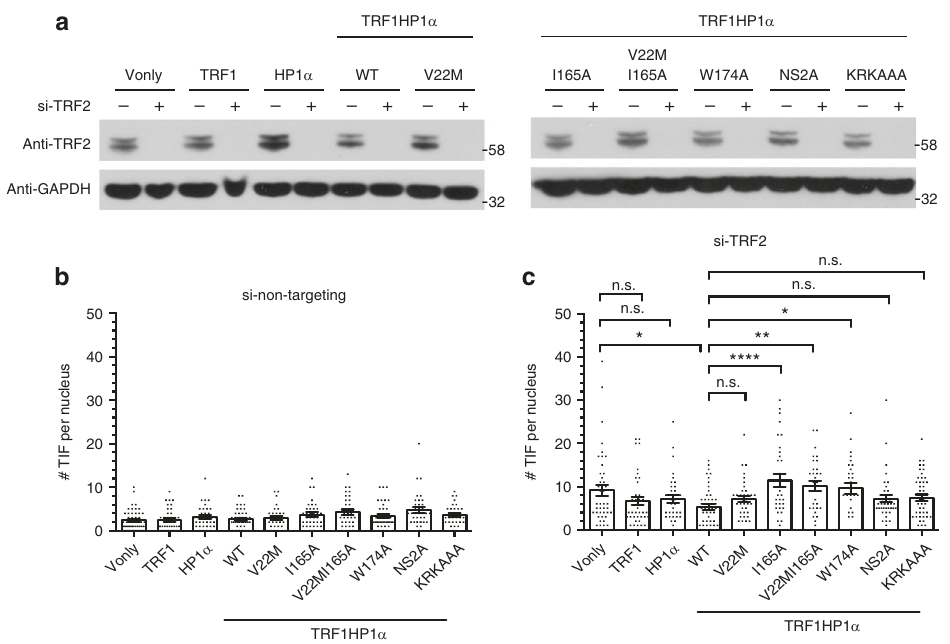
Fig. 5 TRF1HP1 α allele-speci fi c protection effects upon si-TRF2-induced telomeric damage. 72 h after transfection, a TRF2 knockdown ef fi ciency with antibody against TRF2 (anti-TRF2) and GAPDH (anti-GAPDH) as loading control. ( − ) si-non-targeting; ( + ) si-TRF2. Quanti fi cation of TIFs in b si-non- targeting ( n = 32 – 47 nuclei per group) or c si-TRF2. Left * p = 0.0188, right * p = 0.0192, ** p = 0.0042, **** p < 0.0001 ( n = 31 – 48 nuclei per group). b , c Signi fi cance is assessed by one-way ANOVA and Dunnett ’ s multiple comparison test with 95% con fi dence level. Error bars represent s.e.m. Note the similar pattern among TRF1HP1 α alleles in c compared to the corresponding allele pattern in Fig.